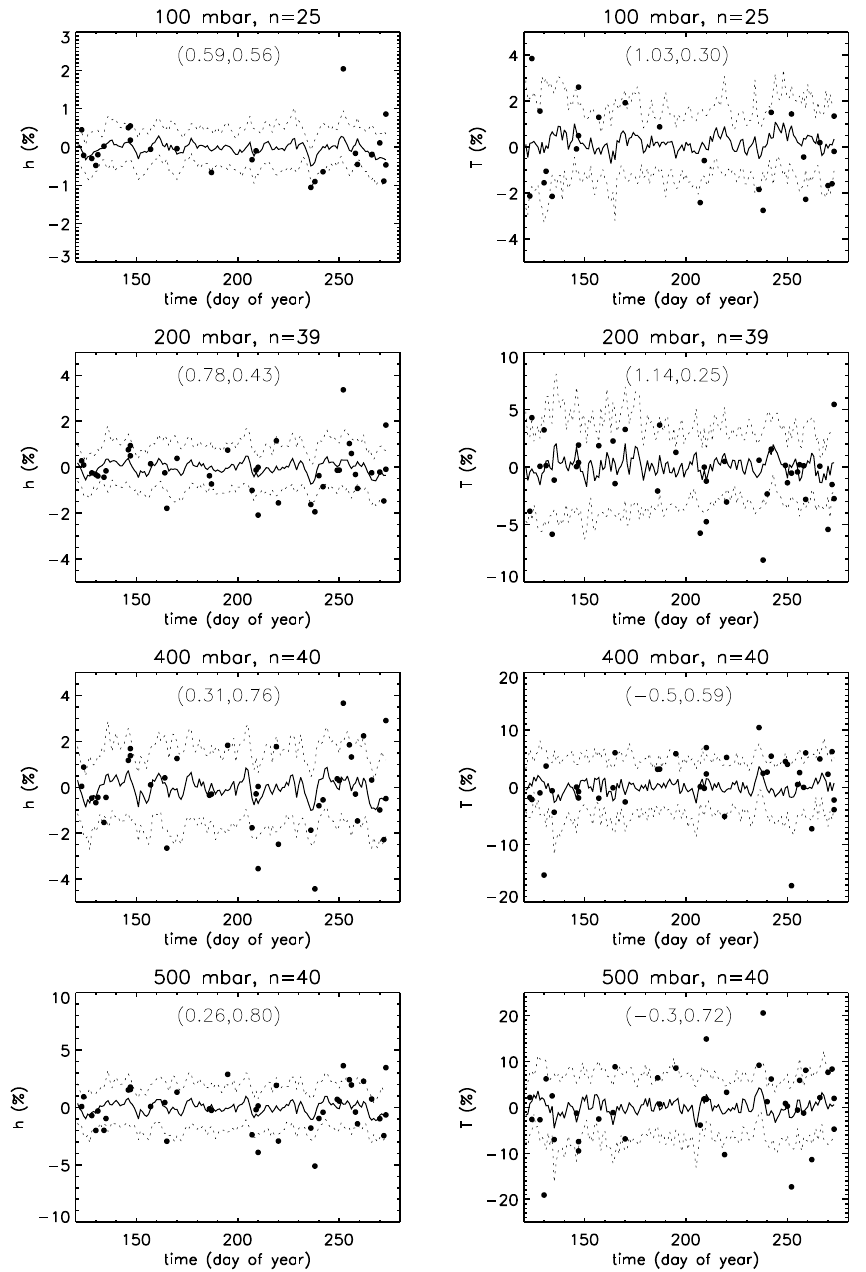
Fig. 2. South Pole winter meteorological data in the form of scatter plots, with those relating to isobaric height in the left-hand column and to isobaric temperature in the right-hand column. The title of each plot gives the pressure level and the number of storm dates (number of spots), n , with good data. The solid line shows the mean (over all years of data used) of the difference between the daily value and the running-monthly-mean value, as a percentage of the running-monthly-mean value. The dashed lines have been placed a standard deviation above and below the mean. The numbers in brackets within each plot give the t -test statistic and its significance for the difference between the means of the complete winter data set and the data set associated with geomagnetic